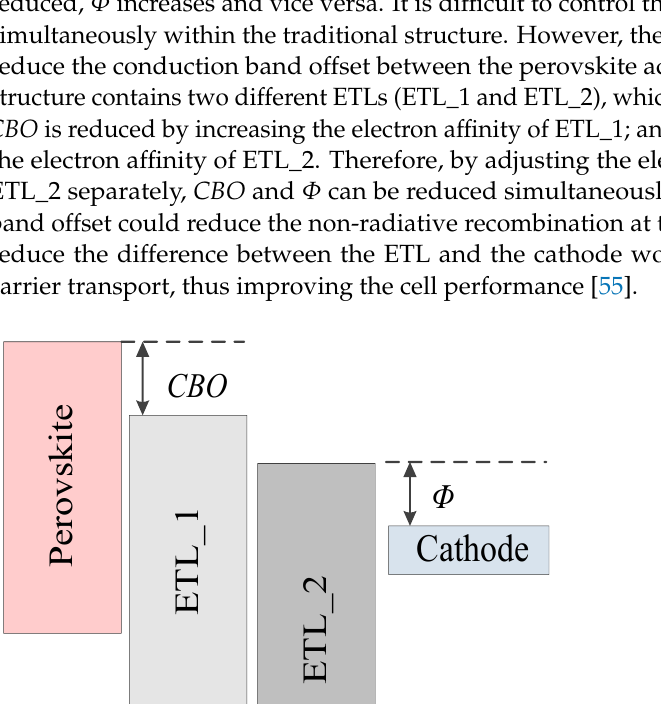
Figure 8. Effect of Φ on the band structure and total recombination: ( a ) band structures under different Φ values, ( b ) total recombination with different Φ values.